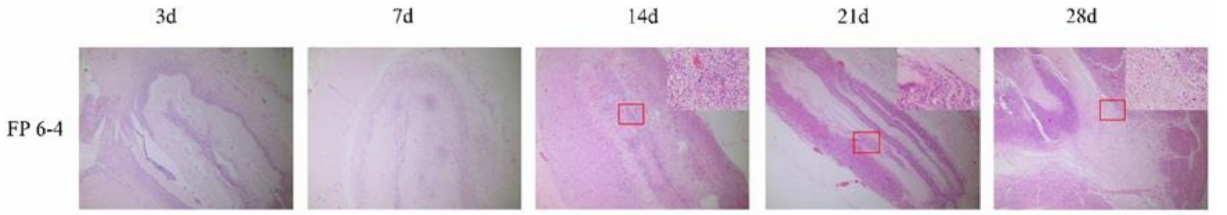
Figure 9. HE staining of degradation of FP 6-4 nanofiber membrane (scale bar: